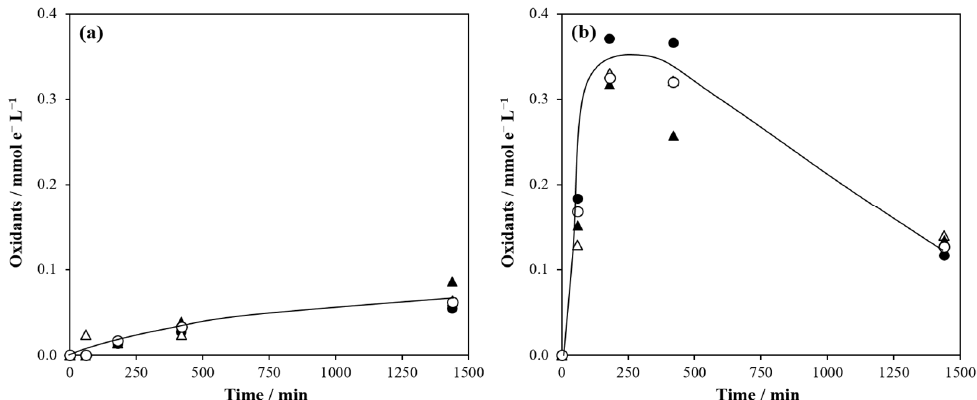
Figure 3. Oxidation capacity of the gases produced from the chlorine production reactor: ( a ) 10 mL of chlorate (5 g L − 1 ), 6 mL of hydrogen peroxide (3300 mg L − 1 ) and 25 mL of sulfuric acid (5.0 M) at 50 °C, ( b ) 10 mL of chlorate (5 g L − 1 ), 4 mL of hydrogen peroxide (3300 mg L − 1 ) and 25 mL of sulfuric acid (5.0 M) at 83 °C. Number of repetitions: 4. Legend Figure 1a: Test Q1 ( ● ), test Q2, test Q3 ( ▲ ) and test Q4 ( ○ ). Legend Figure 1b: Test Q5 ( ● ), test Q6 ( ∆ ), test Q7 ( ▲ ) and test Q8 ( ○ ).